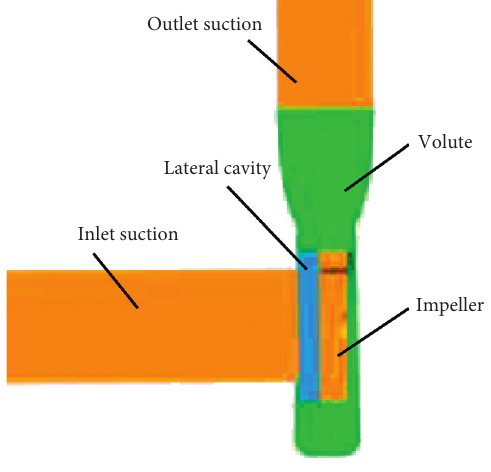
Figure 2: Calculation domains. Table 2: Mesh independent